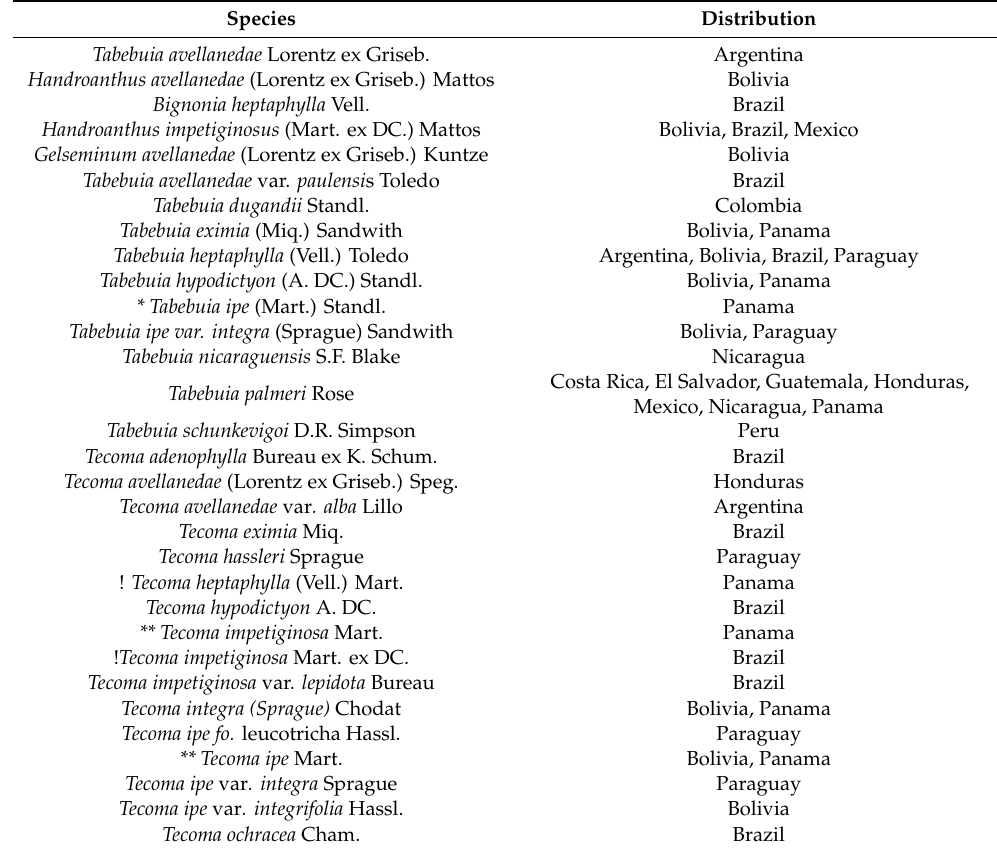
Figure 1. Distribution map of Tabebuia impetiginosa. Table 2. Geographical distribution of Tabebuia impetiginosa.